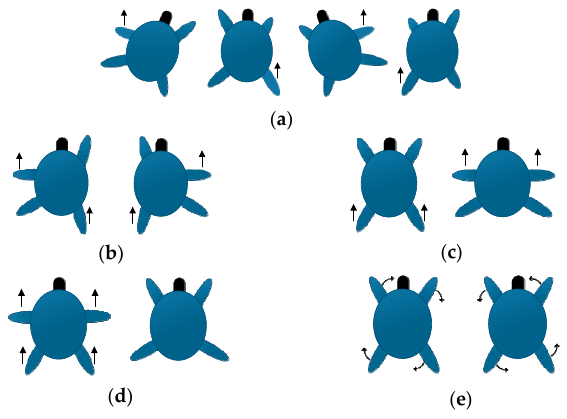
Figure 6. Turtle gaits (The black arrow indicates that the leg is in transfer phase). ( a ) The tripod walking gait (TPWG); ( b ) the trotting walking gait (TTWG); ( c ) the synchronous sliding gait with two legs (SSGTL); ( d ) the synchronous sliding gait with four legs; ( e ) the rotary sliding gait with zero radius.